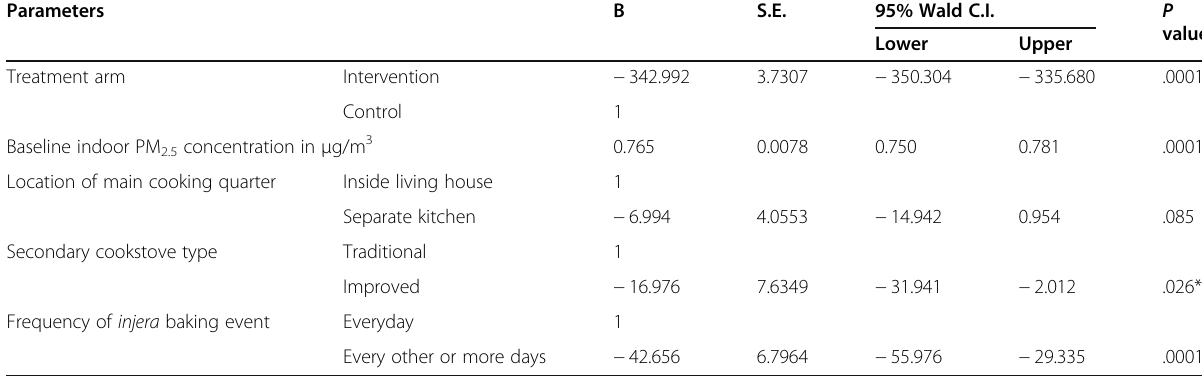
Table 2 Effect of the improved cookstove intervention on the concentration of household air pollution in micrograms per cubic meter of sampled